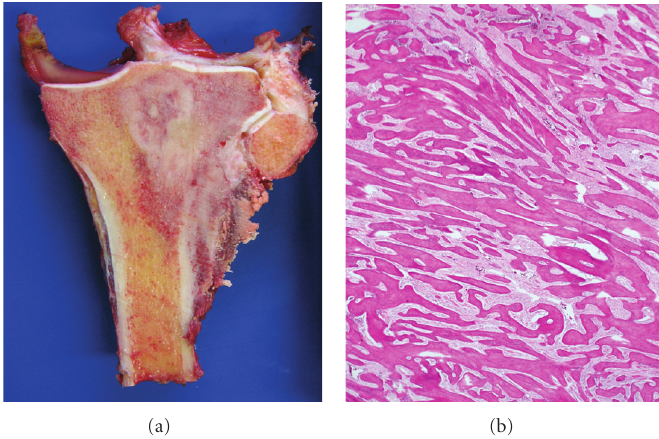
Figure 3: A histological example of LGCO: macroscopically, this greyish white tumour shows extramedullary extension (a). Microscopic review (haematoxylin and eosin stain, × 10) demonstrates (b): low-grade intramedullary osteosarcoma, which consists of parallel seams surrounded by spindle cell stroma which exhibits very minimal cytological atypia. The appearances are similar to parosteal osteosarcoma or fibrous dysplasia, for which it can be